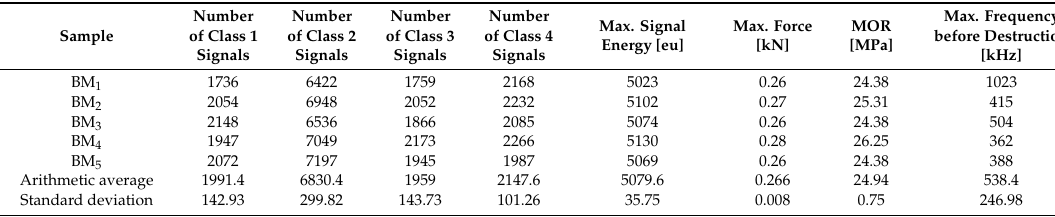
Table 6. Summary of research results for BM